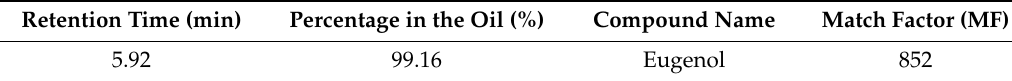
Table 3. GC-MS results for the extract of Syzygium aromaticum